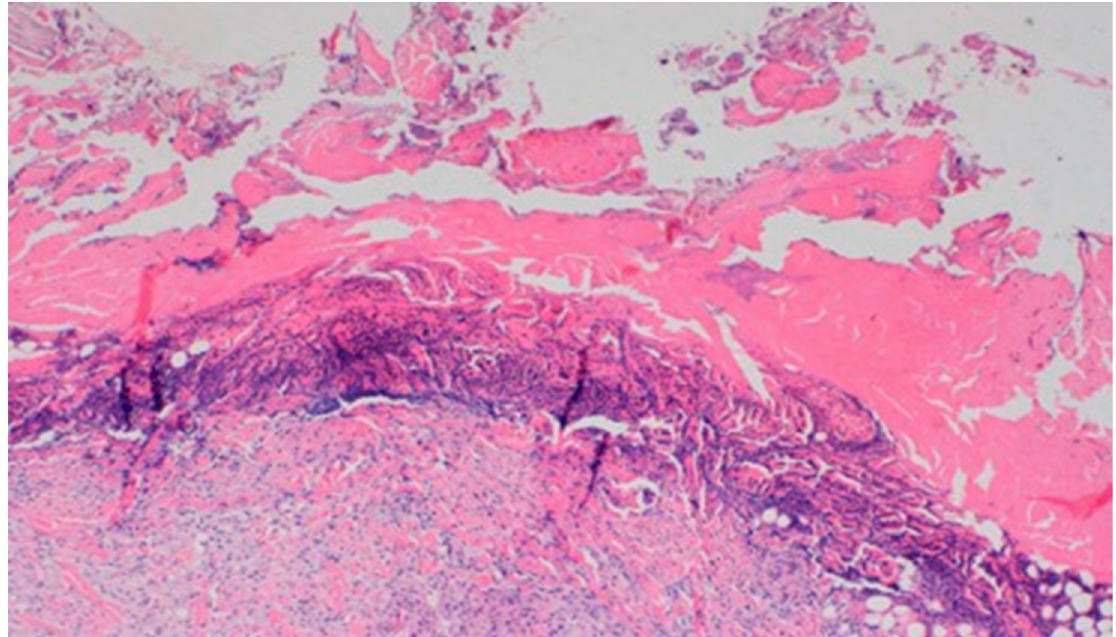
Figure 16. Slight superficial necrosis. Moderately intense granulocytic inflammatory infiltration in the dermis (40×, H-E), in the wound treated with the 1% nanosilver ointment, on day 10.